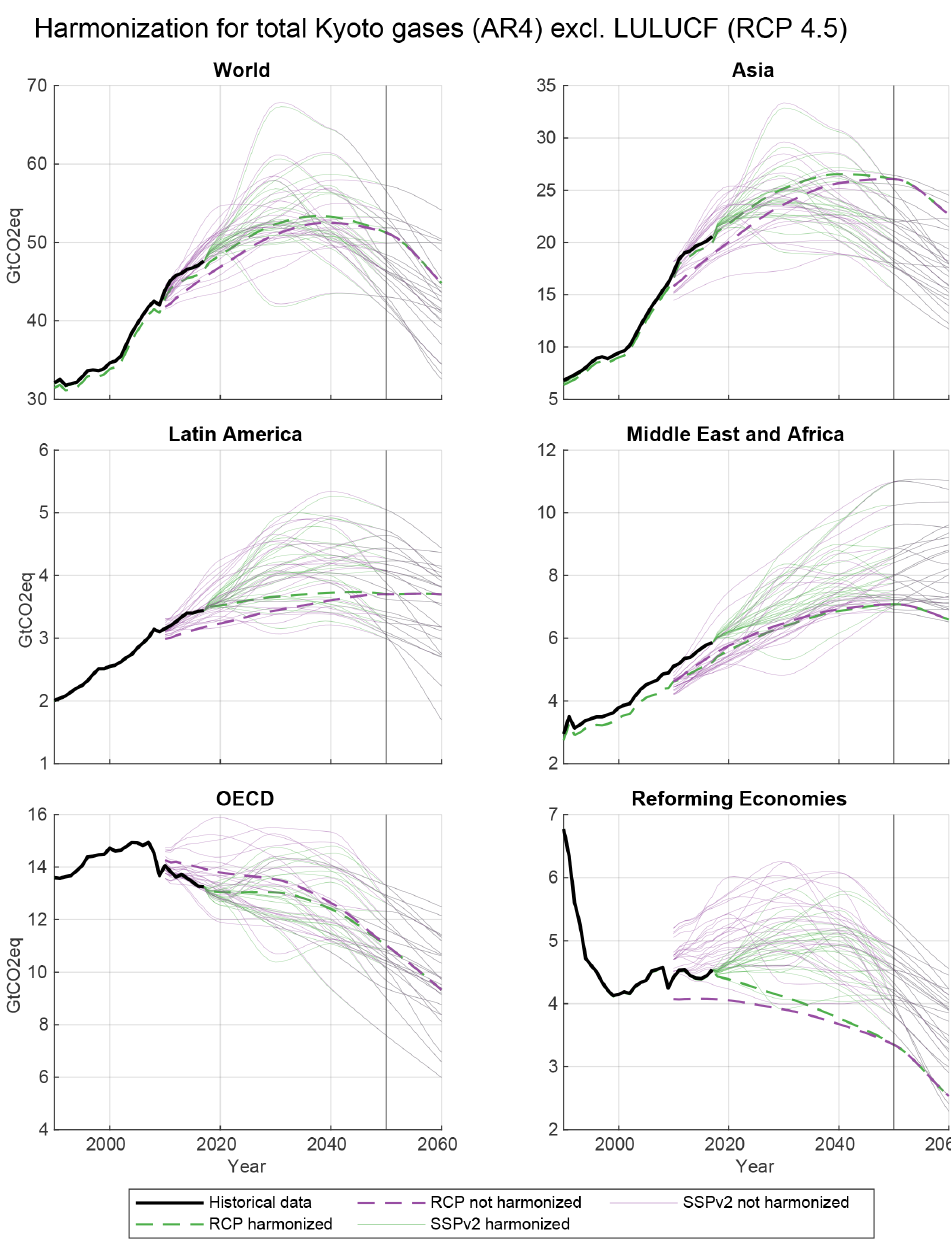
Figure 5. Harmonization of emission scenarios to historical data. The harmonization factor is phased out until 2050. The regions shown here are built from downscaled data to harmonize the region definitions of the SSPv2 scenarios to the RCP regions. As the region definitions of some IAMs do not cover all countries, the aggregate data are in some cases lower than the historical data (see, e.g., the Middle East and Africa region). Harmonization factors are similar for all RCPs, as the IAM groups use the same historical data for all their scenarios. Harmonization factors for individual gases, especially fluorinated gases, can be larger (or in the case of CO 2 smaller). See Sect. S2.2 in the Supplement for